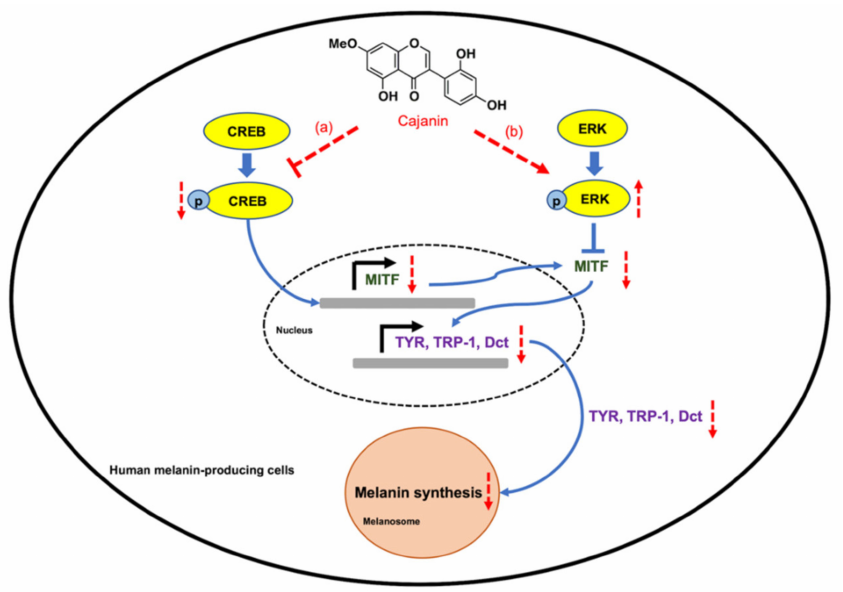
Figure 8. Schematic diagram presenting a proposed anti-melanogenic activity of cajanin in human melanin-producing cells. Cajanin modulates MITF, a melanogenic transcription factor, at both pre- and post-translational steps through down-regulation of pCREB/CREB and activation of pERK/ERK signal, respectively. ( a ) At the initial period of treatment (24–48 h), the inhibition of pCREB/CREB signaling corresponds with decreased mRNA and protein levels of MITF and tyrosinase (TYR) mediated by cajanin. ( b ) Interestingly, the activation of pERK/ERK might play a role on dramatic decrease of MITF protein which consequently attenuates the expression levels of melanin synthesis enzymes, including tyrosinase (TYR), TRP-1 and Dct (TRP-2) at the latter time point (72 h). These modulations on melanin-regulating proteins eventually result in the prolong decreased melanin content in cajanin-treated melanocytes. The red arrows and red symbols indicate the effect of cajanin in human melanin-producing cells. Supplementary Materials: The following are available online, Figure S1: Growth curve of MNT1 cells, Figure S2: The melanin production in MNT1 cells after culture for 0–24 h., Figure S3: Tyrosinase activity in MNT1 cells cultured for 0–12 h., Figure S4: The mRNA expression levels of melanogenesis-